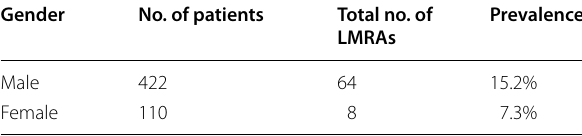
Table 6 Prevalence of LMRA in terms of KT-2000 anterior